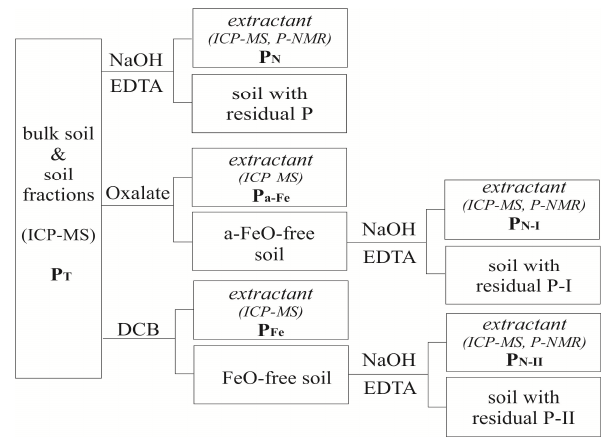
Figure 1. A schematic diagram of the soil sample treatments.